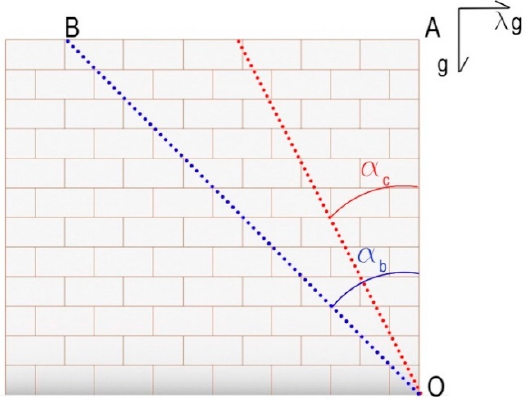
Figure 2. Schematic representation of the cracks line. α b: inclination of the half-unit shape; α c: actual crack inclination.